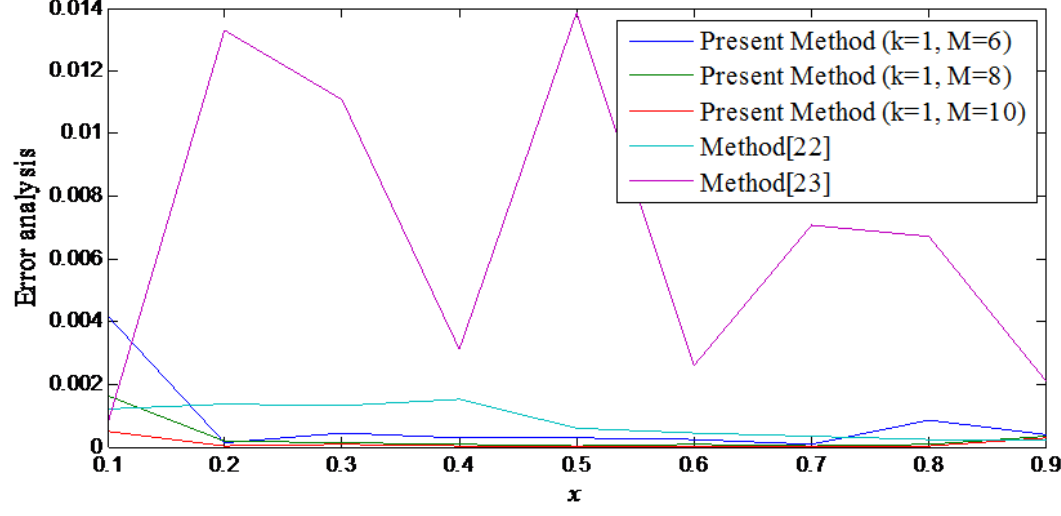
Fig. 3 Comparison of error analysis of example 2.